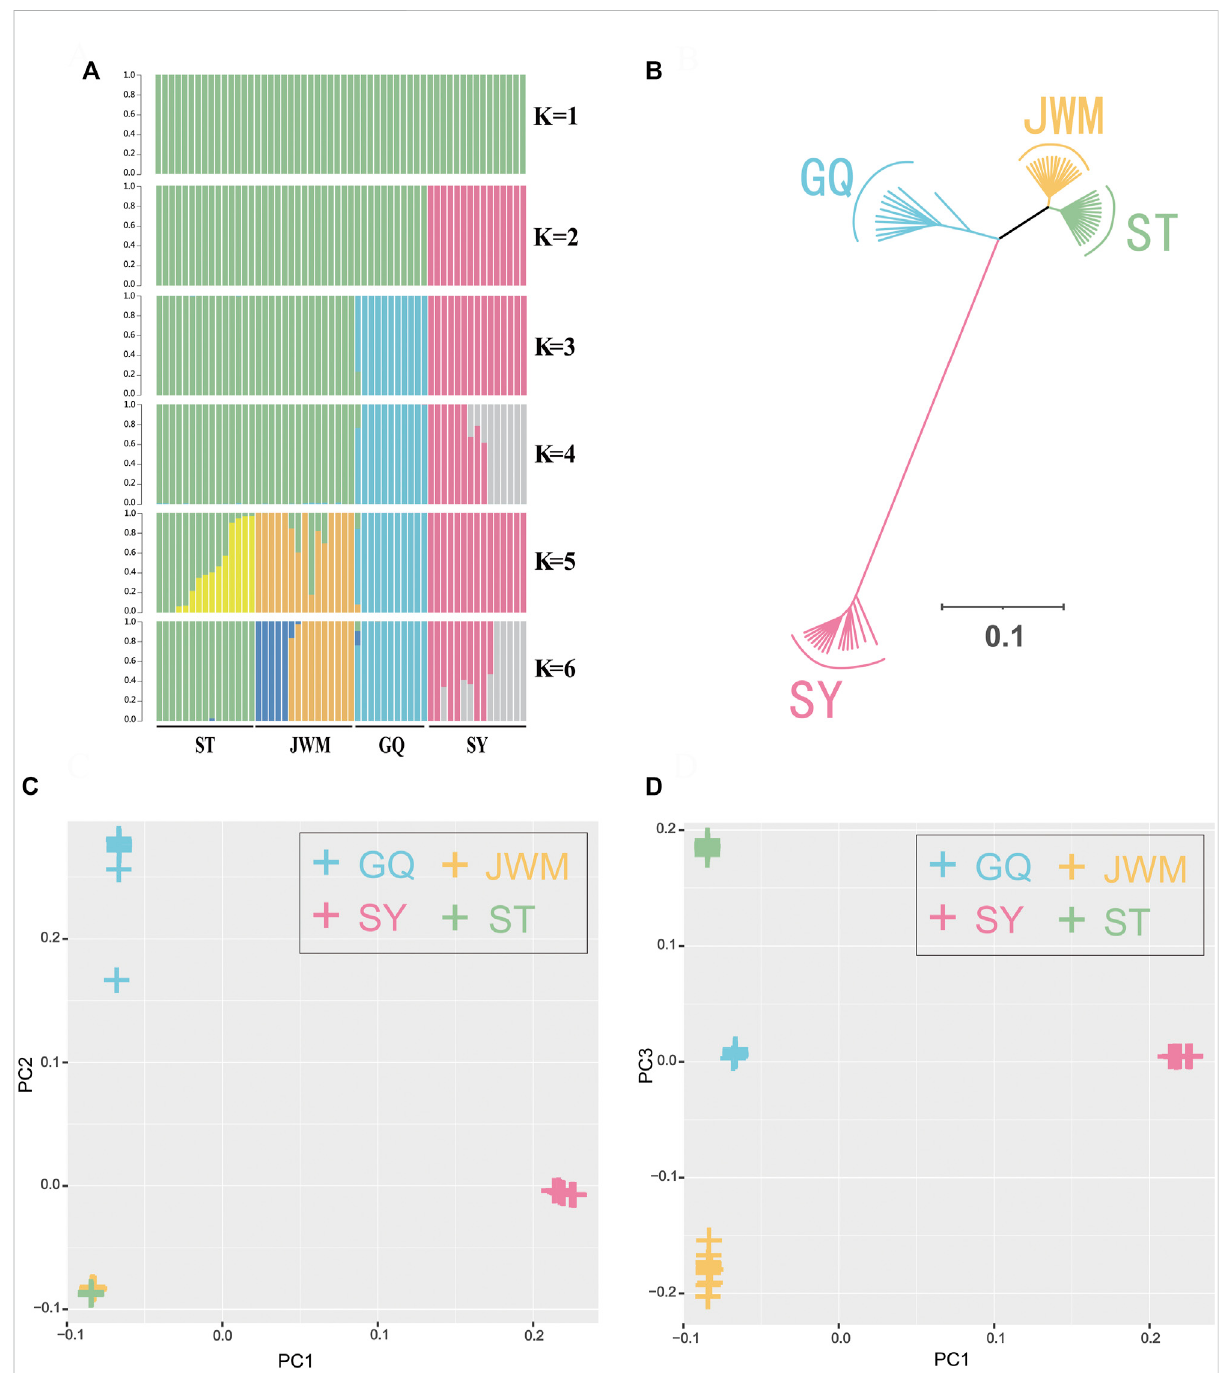
FIGURE 3 Population genetics. (A) Genetic structure of the O. curvinotus as inferred by Admixture analysis. The number of populations (K) from 1 to 6 is shown. Each color represents a different hypothetical ancestor. (B) Unrooted tree generated by the neighbor-joining method with 1000 bootstrap. (C,D) The principal component analysis (PCA) of all